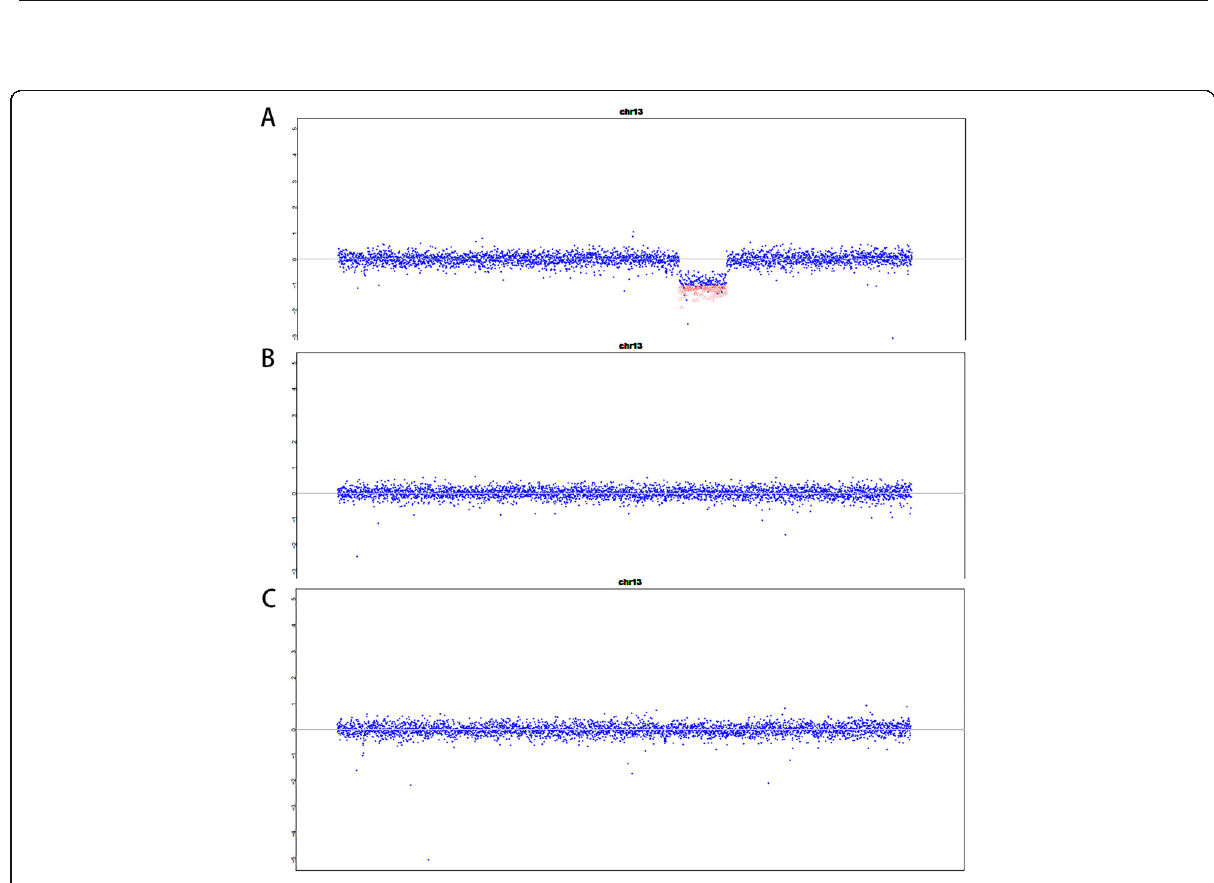
Fig. 4 CNV analysis revealed a heterozygous deletion on chromosome 13 at 13q21.33q31.3(72,306,245 – 79,485,372) in proband ( a ), the deletion was absent from the paternal ( b ) and maternal ( c )